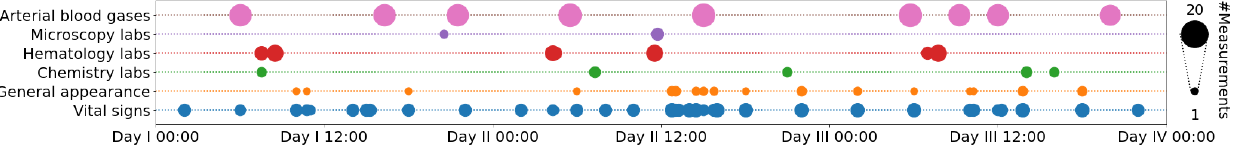
Figure 2. Illustration of our sequential clinical data randomly selected from a patient in the dataset during their 72 h stay in the ICU. The graph shows how often the clinical variables were measured, with more measurements during the day than at night.